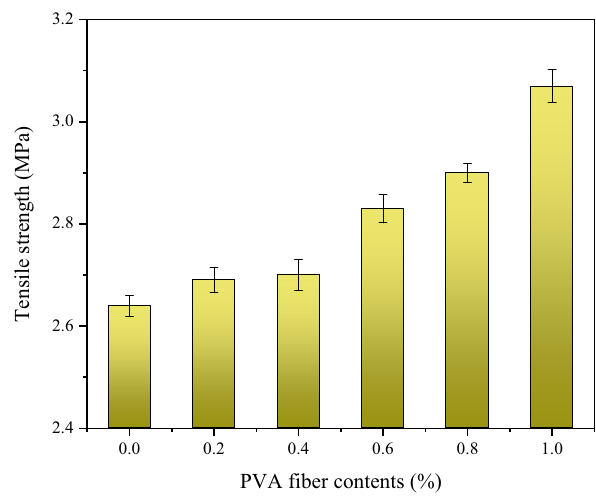
Figure 15: Tensile strength versus PVA fi ber